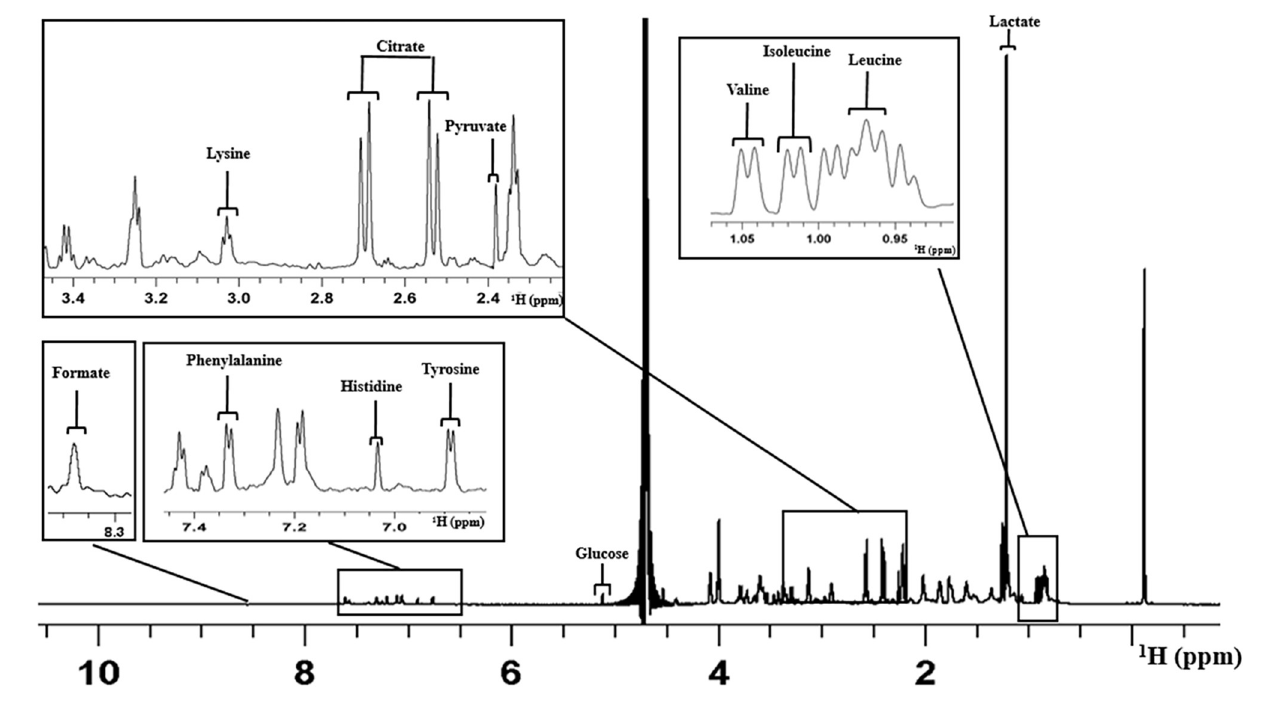
Fig 1. Representative figure of 1D 1 H NMR spectrum of the one-step embryo culture medium used in this study. The figure elucidates the assignment of peaks for different metabolites. X-axis represents the chemical shift in parts per million.